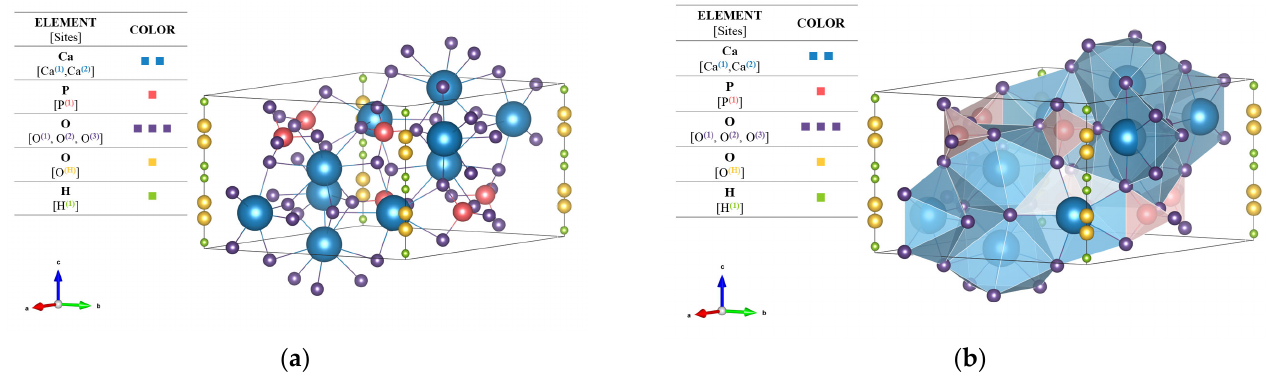
Figure 2. Rendered structural ( a ) ball-and-stick and ( b ) polyhedral images of HAp_900 ◦ C (standard orientation of crystal shape).